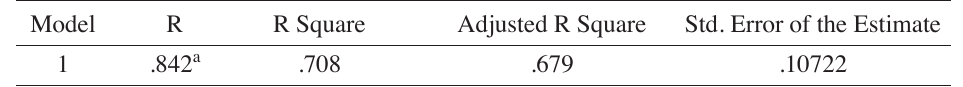
Table 3: Model Summary Analysis